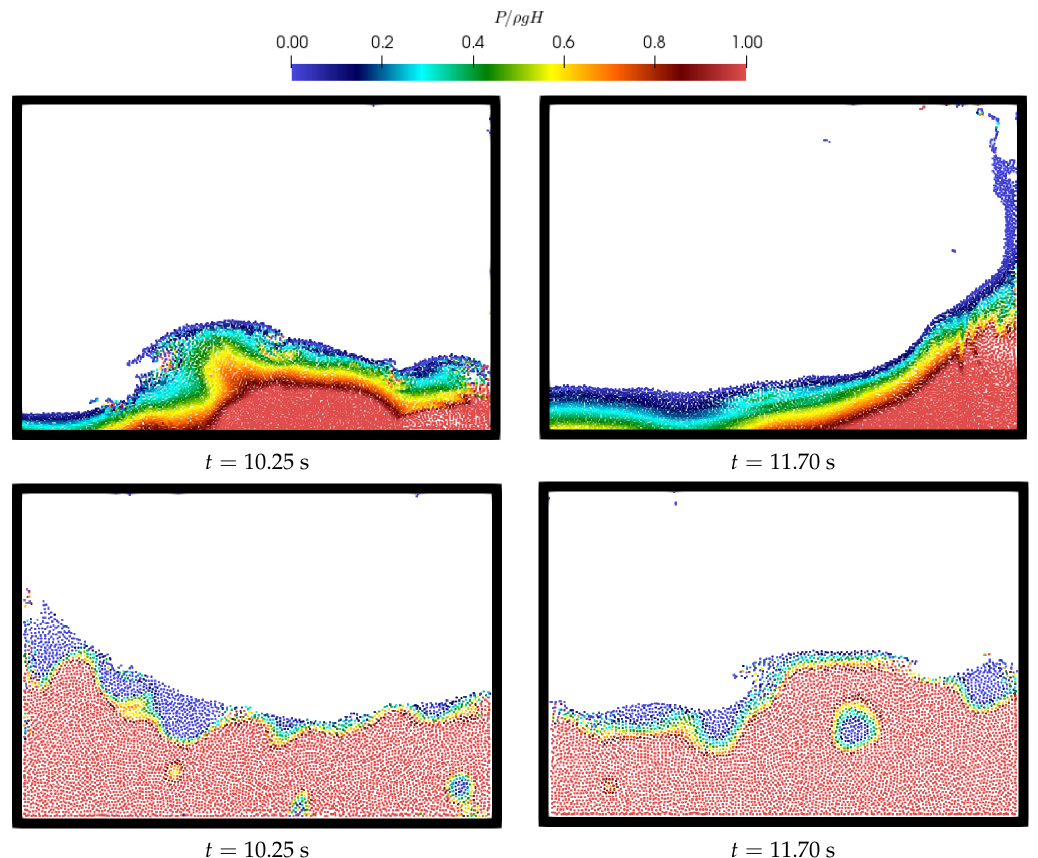
Figure 31. Sloshing in a rectangular tank: Snapshots of pressure field at times t = 10.25 s and t = 11.70 s. The first row depicts the results obtained by the present method. The second row presents the results obtained with IPST